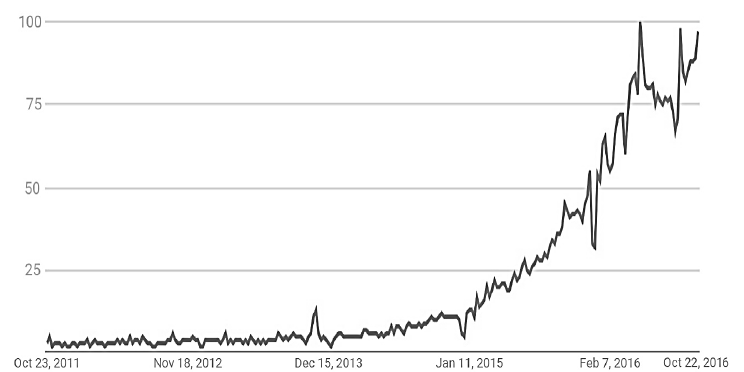
Fig. 1. Popularity of the search term “fintech” at